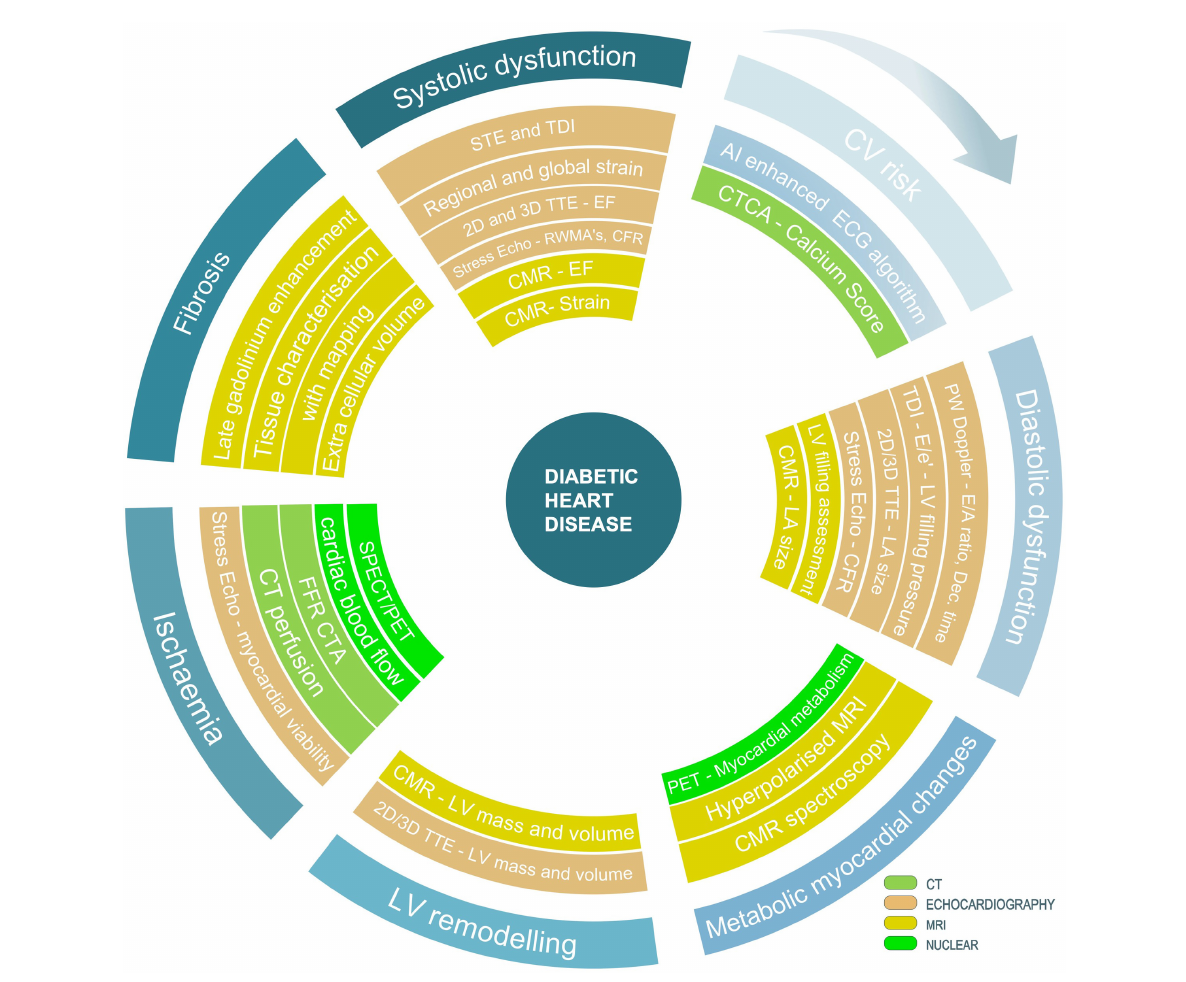
FIGURE4 Suggested strategy of using various techniques and imaging modalities in screening patients with diabetes for signs of diabetic heart disease. Outline of currently available techniques and imaging modalities allowing characterisation of different stages of the disease with focus on processes leading to the development of diabetic heart